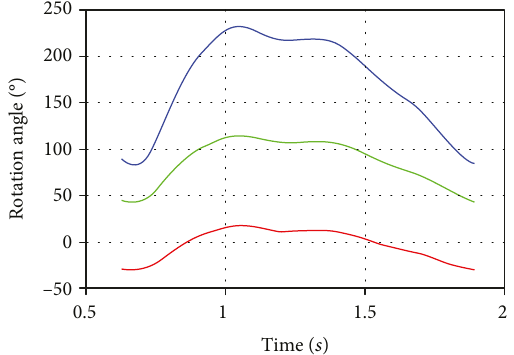
Figure 9: Motion curves of upper part (green solid curve) and lower part (blue solid curve) and thigh (red solid